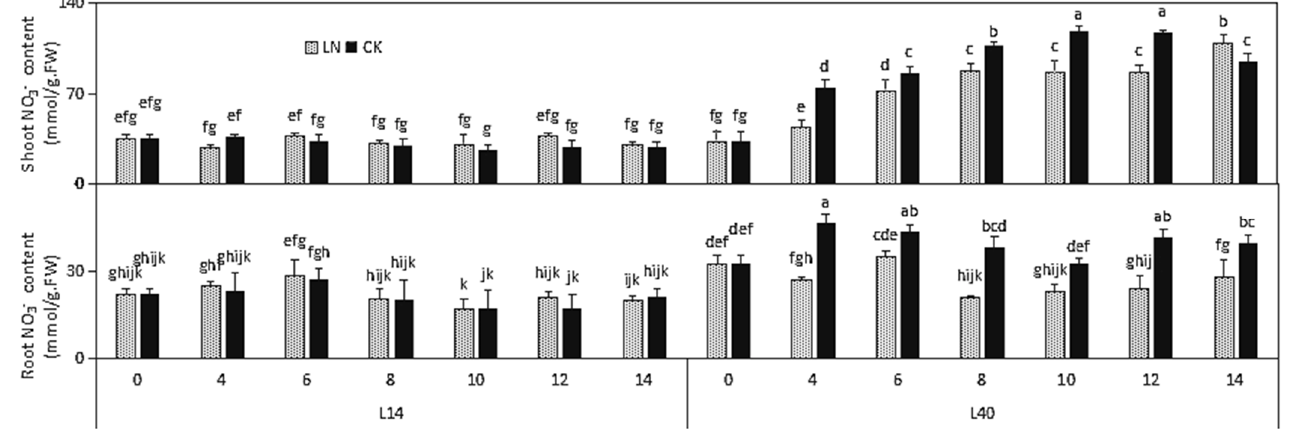
Figure 3. Effects of LN treatment on NO − content in Chinese cabbage genotypes L14 and L40. Values shown are means ± SE; n = 6 (two experiments and three replications of each genotype). Means with different letters are significantly different according to the Duncan test at p < 0.05. NO − content changes under LN stress compared to CK supply are indicated on the bars. The letters “LN” and “CK” indicate whether the N content was low or normal.